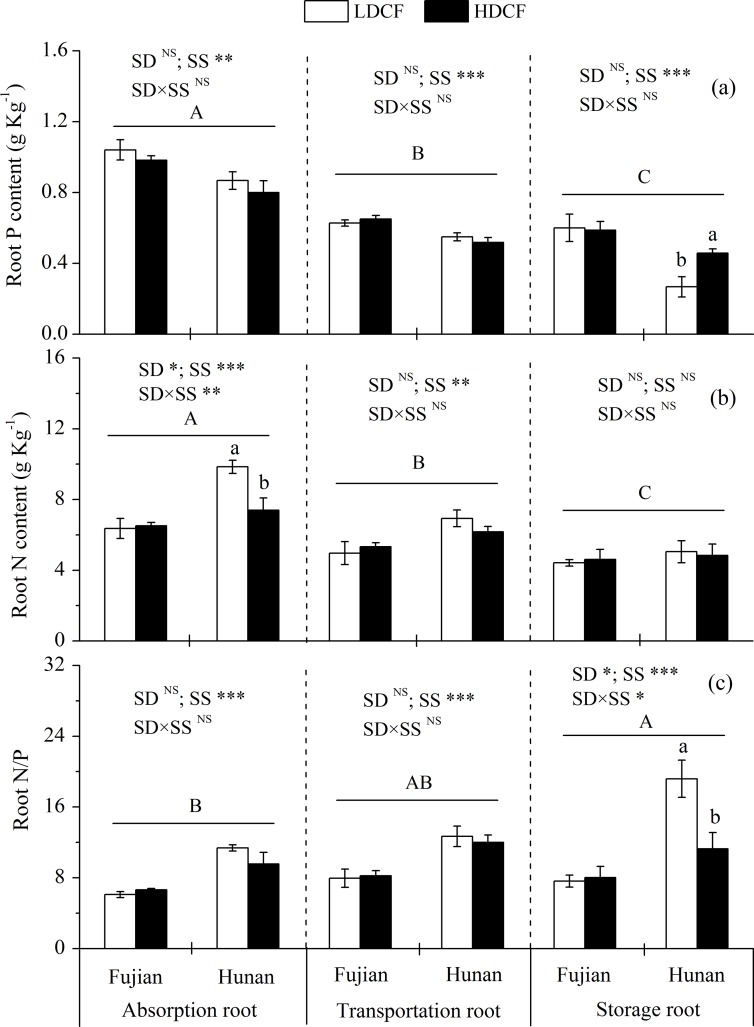
Nitrogen and phosphorus concentrations and their stoichiometry in various functional roots in low density and high density Chinese fir plantations (LDCF vs. HDCF) at two sites of subtropical China.Note: Mean±1 standard error. Different small letters indicate significant differences between LDCF and HDCF in roots of the same age at the 0.05 level. Different capital letters indicate significant differences among roots of different ages at the 0.05 level. SD: stand density. SS: study site. NS not significant, * p < 0.05, ** p < 0.01, *** p < 0.001.